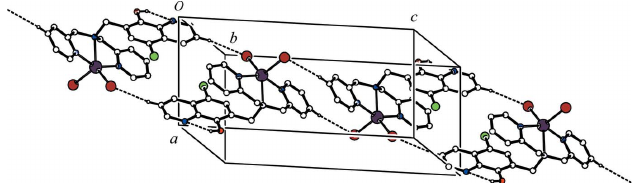
Figure 2 A portion of the crystal packing of the title compound showing the ribbon structure motif built from alternating R 2 H (cid:2)(cid:2)(cid:2) Br hydrogen bonds between the dimers and the intramolecular hydrogen bonds are shown as dashed lines. H atoms not involved in the interactions were omitted for clarity.